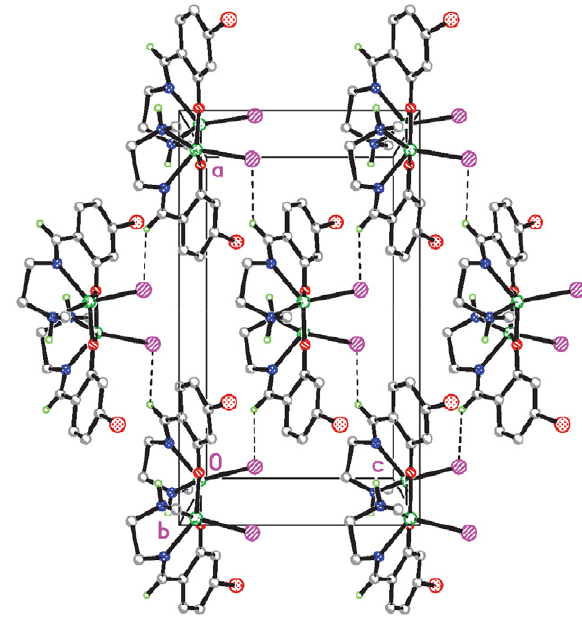
Fig. 4. Molecular packing diagram of complex 2 , viewed along the b axis. Hydrogen bonds are drawn as dashed